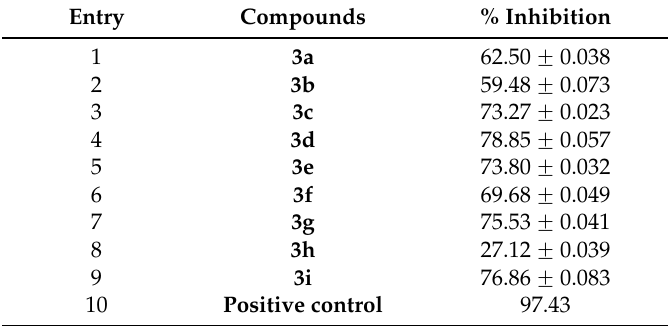
Table 3. Percent inhibition data of 2,5-biaryl-3-hexylthiophene derivatives ( 3a – i ) at 50 µ M/mL.